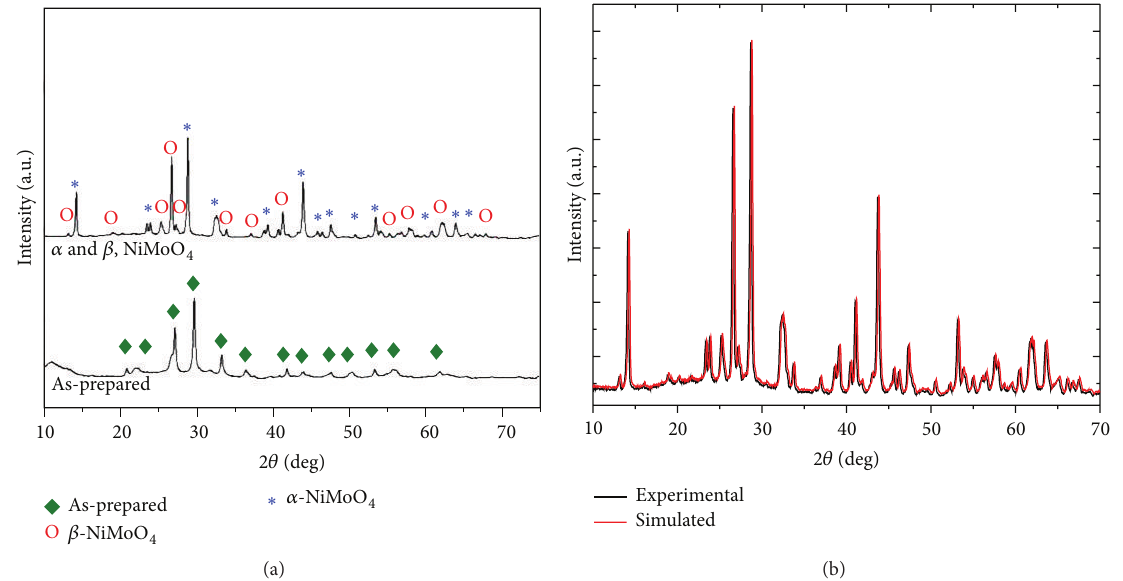
Figure 2: (a) XRD patterns of the as-prepared powder and the powders heated at 600 ∘ C for 10 minutes in a microwave oven together with (b) structural refinements plot for the 𝛼 , 𝛽 -NiMoO 4 nanostructures.